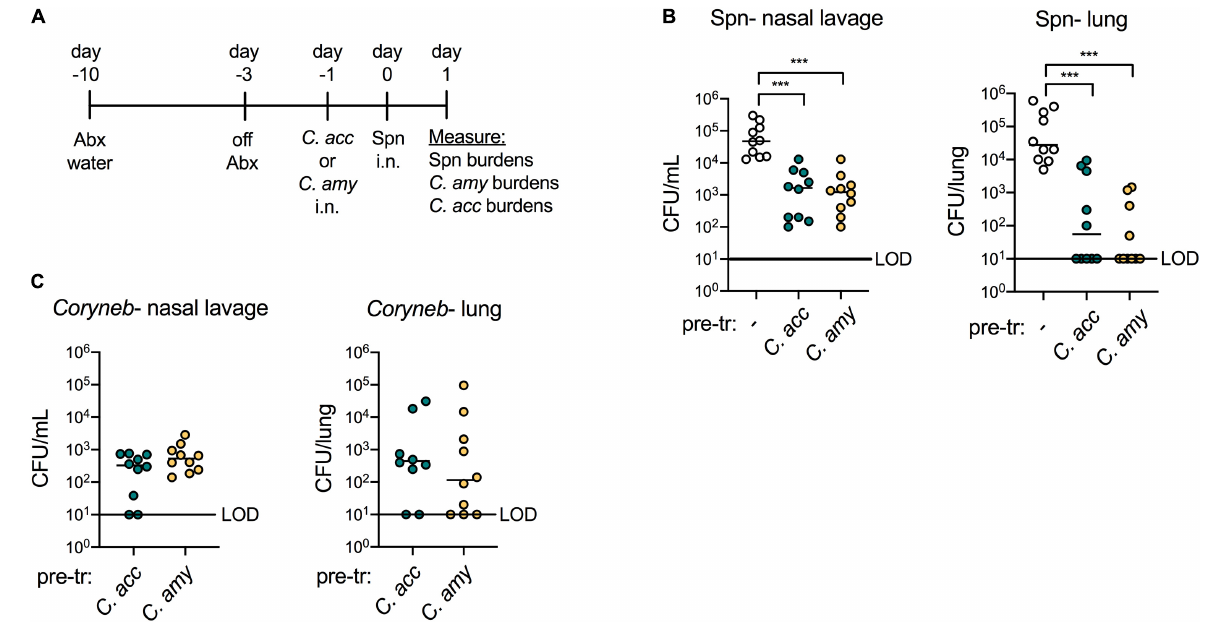
FIGURE 4 | Colonization with Corynebacterium inhibits colonization and infection with S. pneumoniae in vivo. Timeline for antibiotic treatment followed by pre-exposure to PBS (–), C. acc or C. amy prior to infection with S. pneumoniae (Spn) (A) . Burden of Spn (B) or Corynebacterium ( Coryneb ) (C) in nasal lavage fluid and lungs of mice pre-exposed to PBS (–), C. acc or C. amy at 24 h post-Spn infection detected by live growth. Limit of detection (LOD) is indicated. Data are pooled from three independent experiments with 3–5 mice per group. *** p < 0.001, Kruskal-Wallis